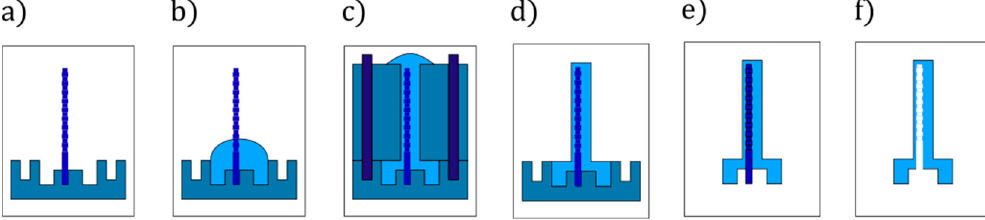
Figure 4. Fabrication process steps. ( a ) WEDG’ed (wire electrical discharge grinding) microrod is placed in the designated hole of the aluminium bottom half of the mould. ( b ) Uncured rubber is poured on the bottom half. ( c ) The top half is aligned and tightened to the bottom half. ( d ) After curing, the top part is removed. ( e ) Microactuator demoulding. ( f ) Microrod removal (figure adapted from [36]).